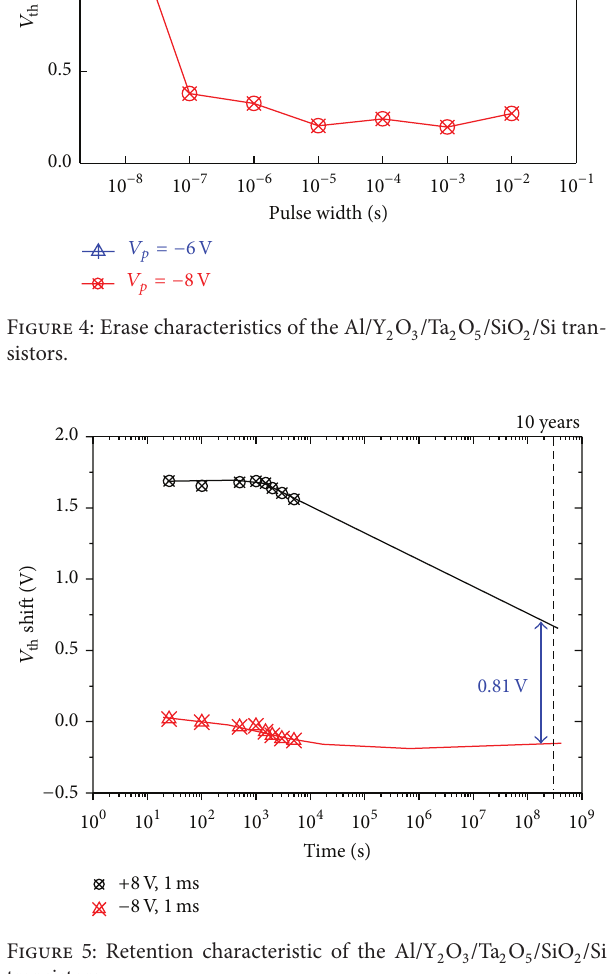
Figure 5: Retention characteristic of the Al/Y 2 O 3 /Ta 2 O 5 /SiO 2 /Si